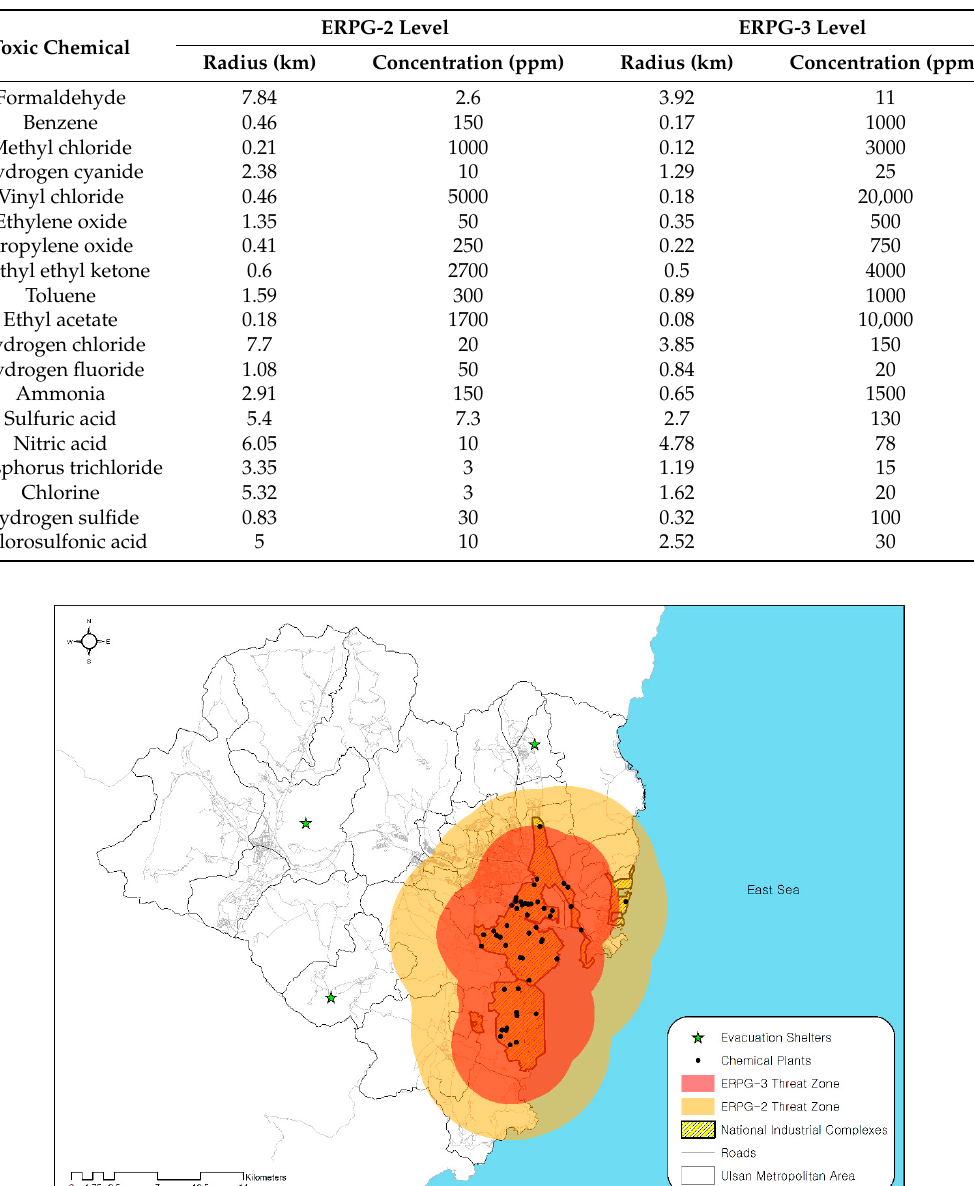
Table 3. Estimated radius of 19 toxic chemicals’ release in each ERPG level.